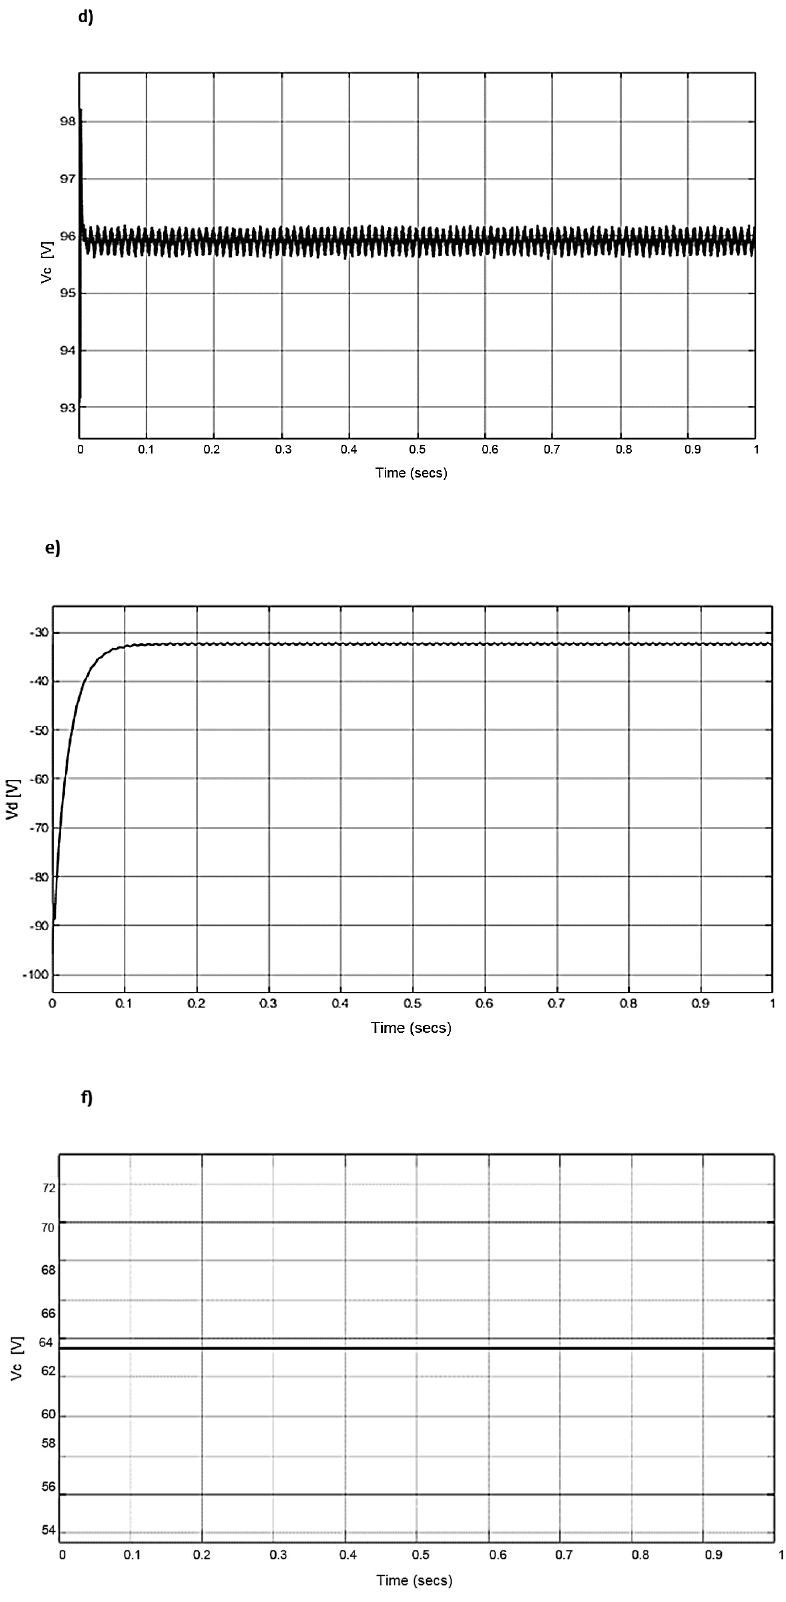
Figure A3. The courses of voltage V 0 , currents I 0 , IL , and voltages V c , V d , and V s versus time for the boost converter for the Li-ion battery, ( a ) V 0 ; ( b ) I 0 ; ( c ) IL ; ( d ) V c ; ( e ) V d ( f ) V s